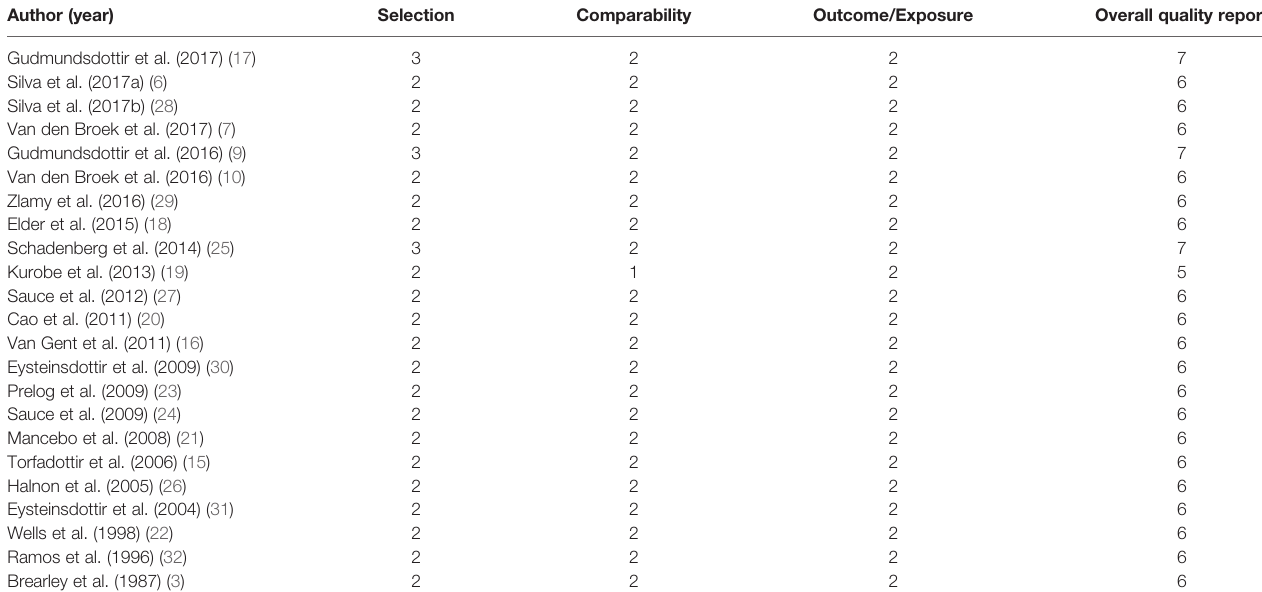
TABLE 2 | Risk of bias of included studies according to the Newcastle – Ottawa